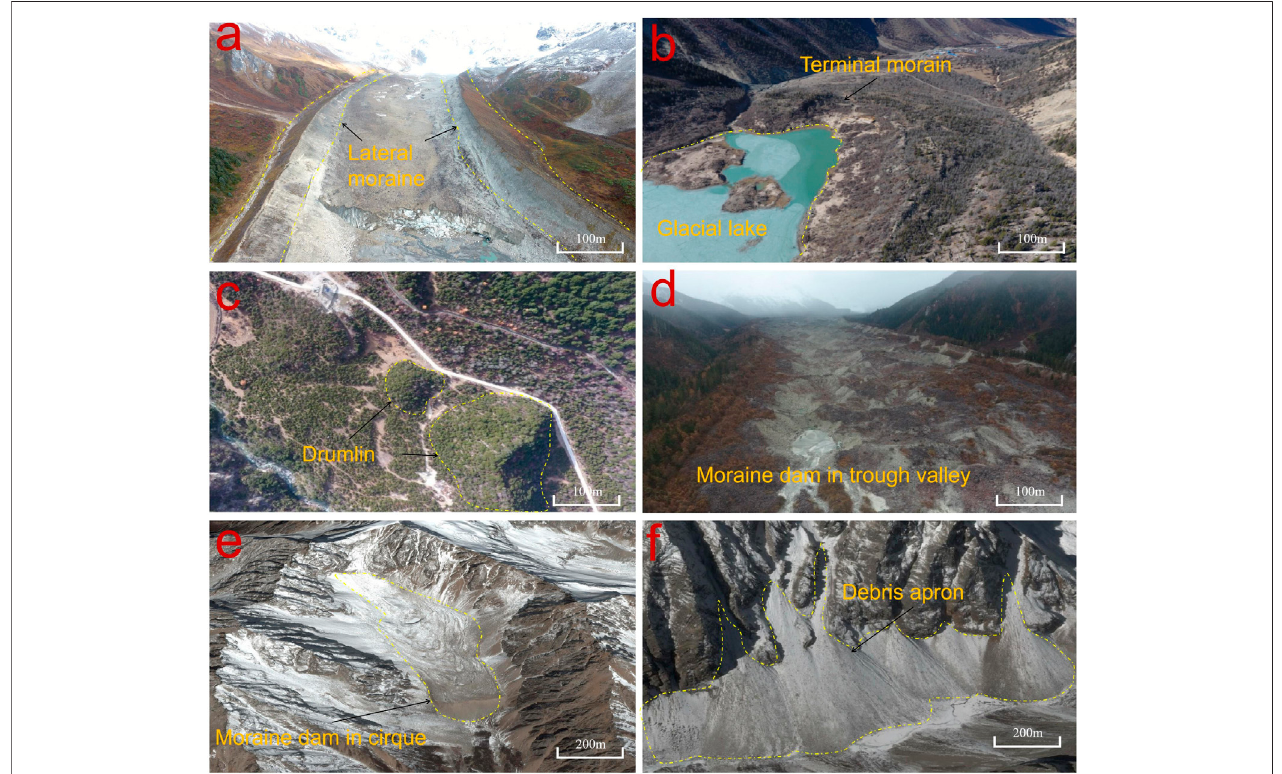
FIGURE2| Typesofmoraine[ (A) Lateralmoraine; (B) Terminalmoraine; (C) Drumlin; (D) Morainedamintroughvalley; (E) Morainedamincirque; (F) Debrisapron].